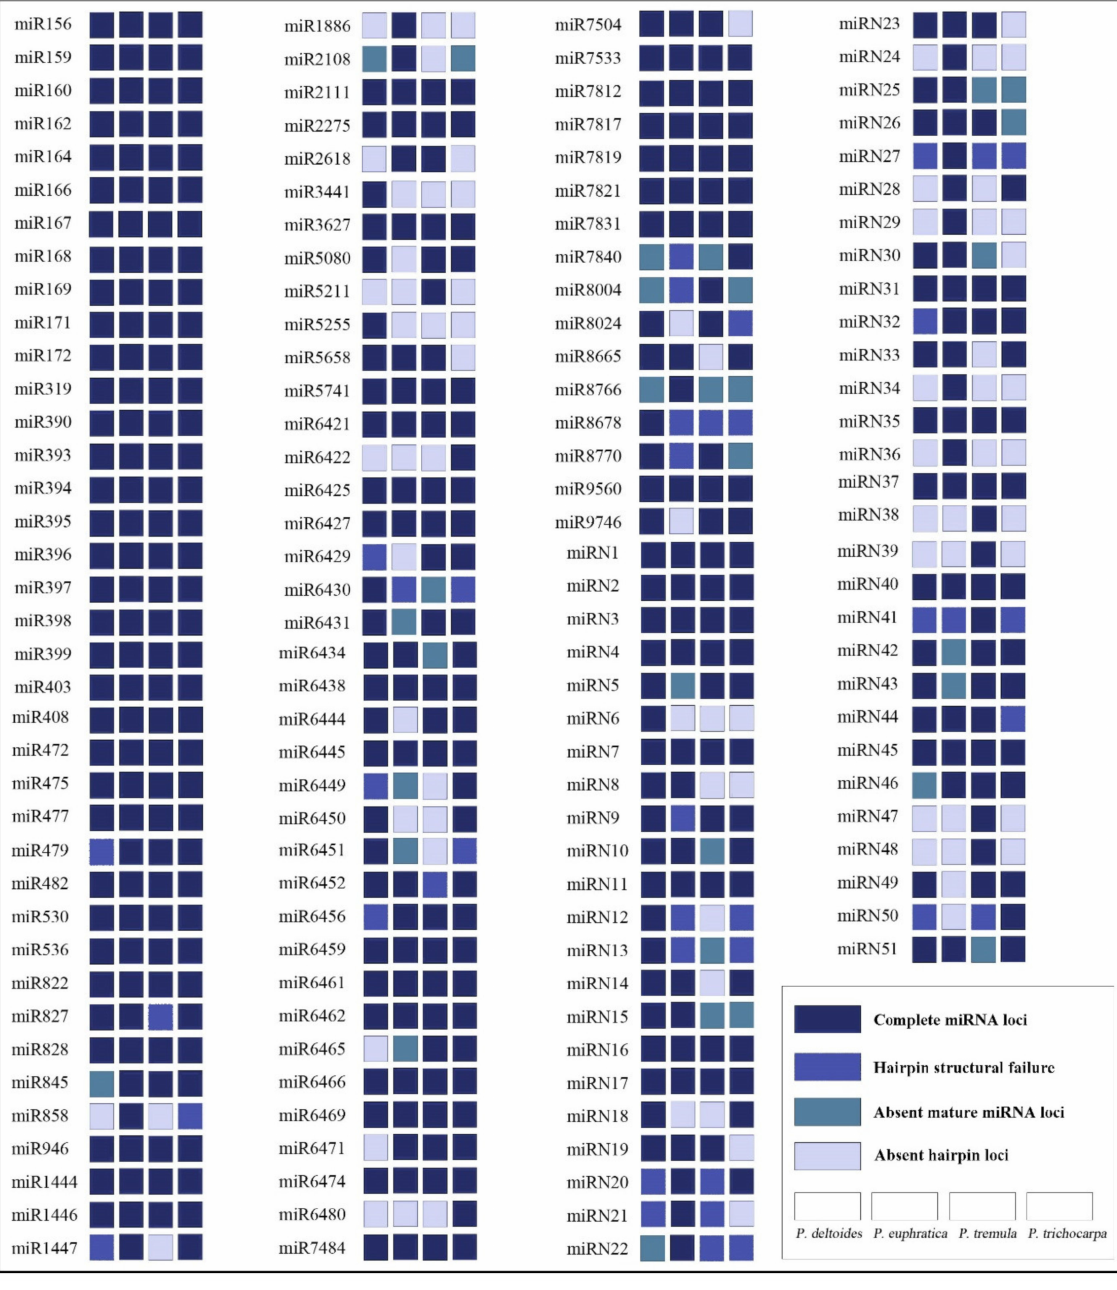
Figure 3. miRNA family alignments and annotations of four poplar